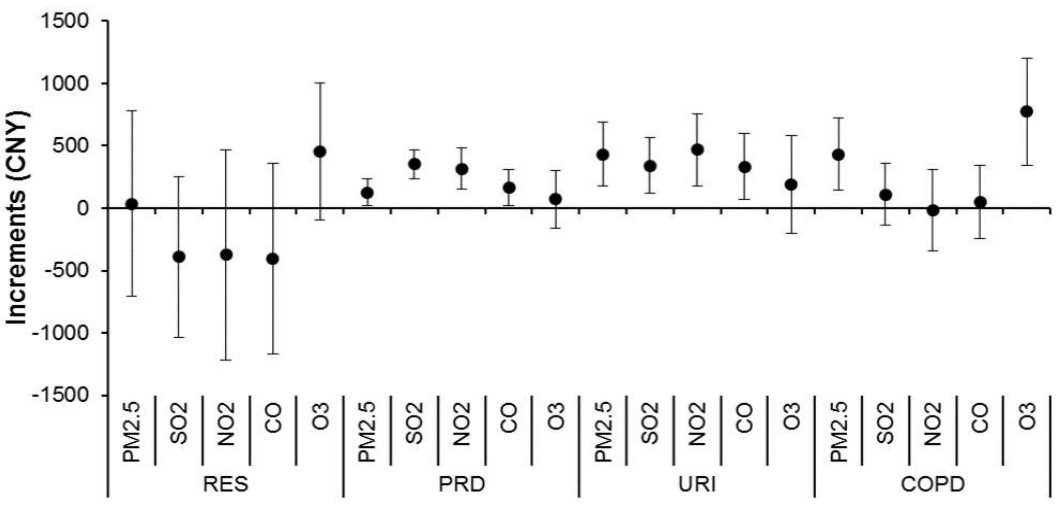
Figure 2. Cumulative increments of daily medical expenditure due to emergency-room visits for respiratory diseases associated with an interquartile range increase in air pollutant concentrations over a lag of zero to three days. Abbreviations as shown in Tables 1 and 2.